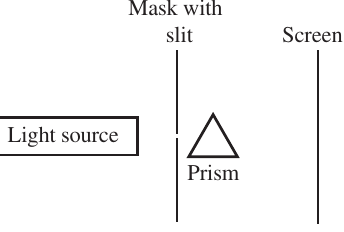
FIG. 1. Common experiment used to view discrete line spectra. If the source is an incandescent bulb, a continuous spectrum is observed. A gas discharge lamp yields a discrete line spectrum. In some cases, a diffraction grating is used instead of a